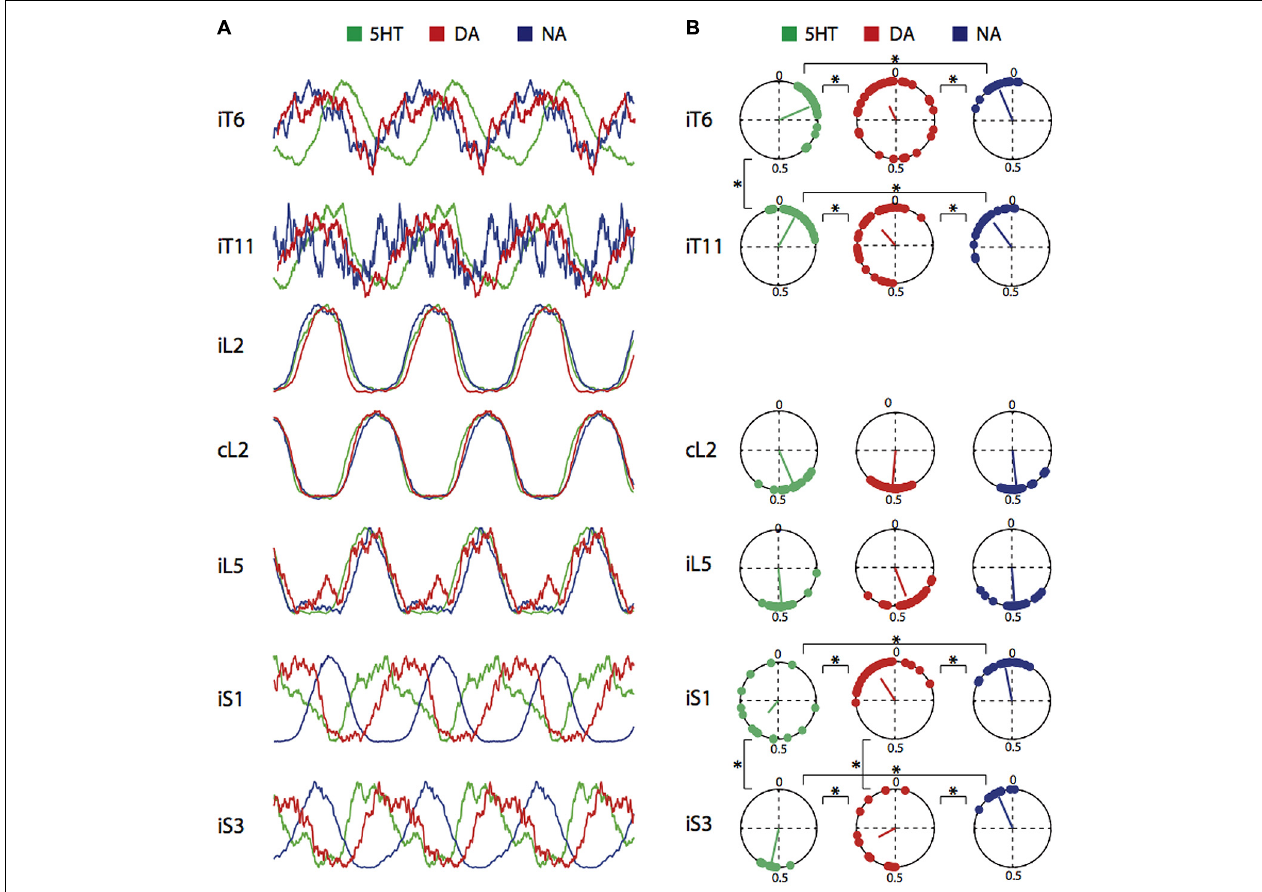
FIGURE 3 | Control of phase relationships by 5-HT, DA, or NA. (A) Averaged and replicated cycle sequences during locomotor-like activity induced by a combination of NMA (15 μ M) and one of the three amines (5-HT, 15 μ M; DA, 50 μ M; NA, 50 μ M). Bursts were normalized for the amplitude. Note phase differences relative to reference L2 bursts shift occurring in the thoracic and sacral segments. (B) Circular plots showing